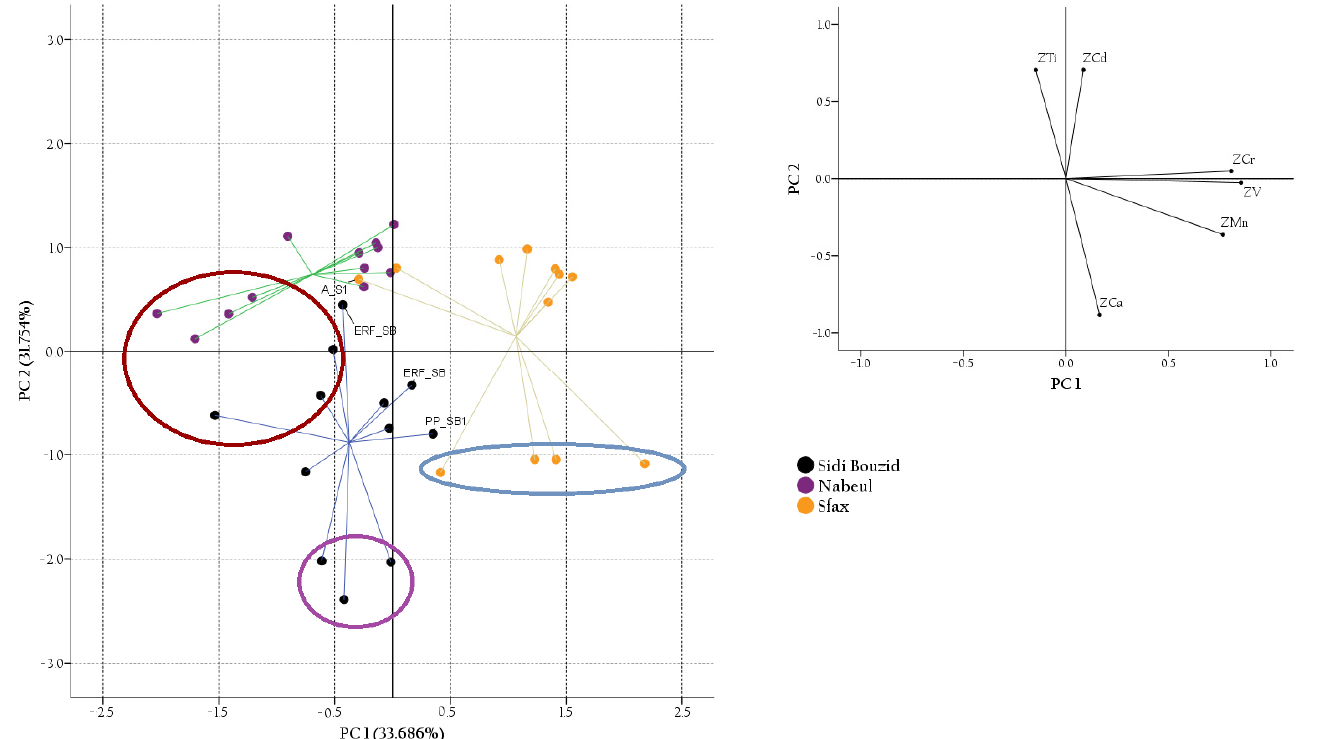
Figure 2. Two-dimensional score plots for the 36 honey samples categorized by geographical origin. Inserts: loadings plot for first principal component (PC1) and second principal component (PC2). Outcome obtained with 17 variables.